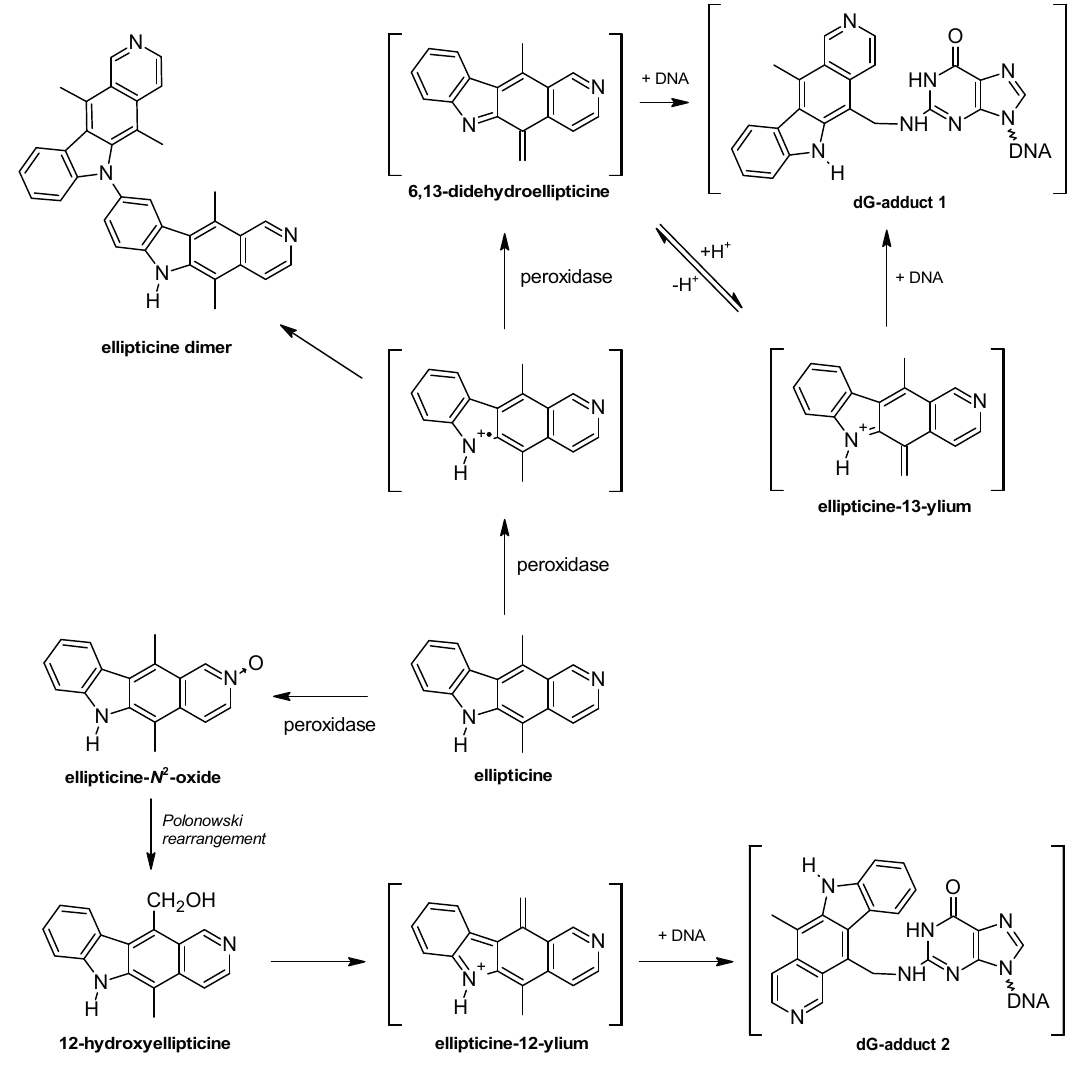
Figure 4. Oxidation of ellipticine by peroxidases showing the characterized metabolites and those proposed to form DNA adducts. The compounds shown in brackets were not detected under the experimental conditions and are the electrophilic metabolites postulated as ultimate arylating species or the postulated N ²-deoxyguanosine adducts (adapted from reference